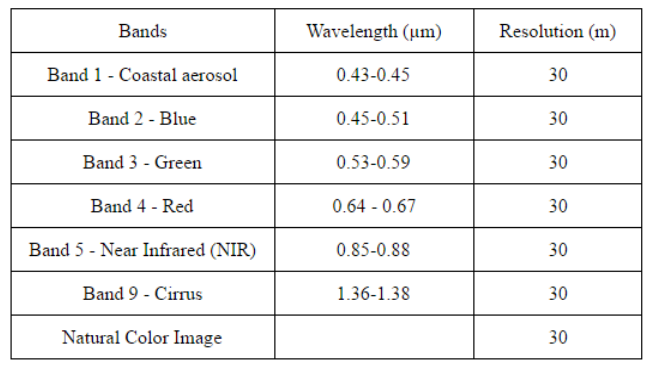
Figure 2: Map showing Andaman and Nicobar Islands in green color.